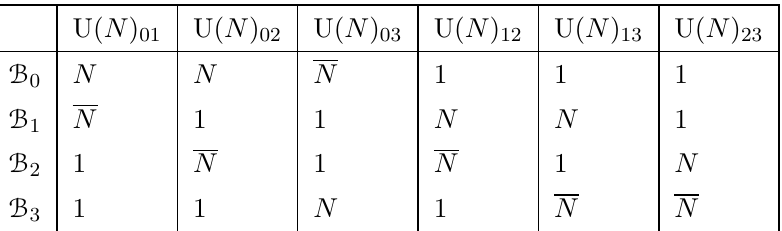
Figure 1 . A three-loop vacuum supergraph in the triple line notation. Indices with subscript 1, 2, and 3 are colored red, green, and blue, respectively. The outer (inner) red loop is associated to a 1 ( b 1 ), while the top (respectively, bottom) green and blue loops correspond to a 2 and b 2 (respectively, a 3 and b 3 ) in eq. (2.13).